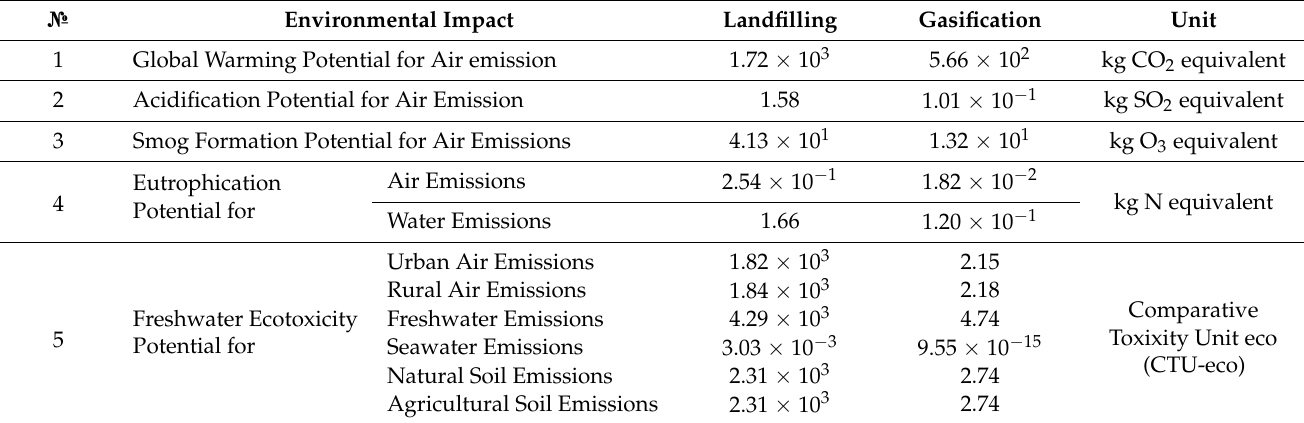
Table 5. Environmental